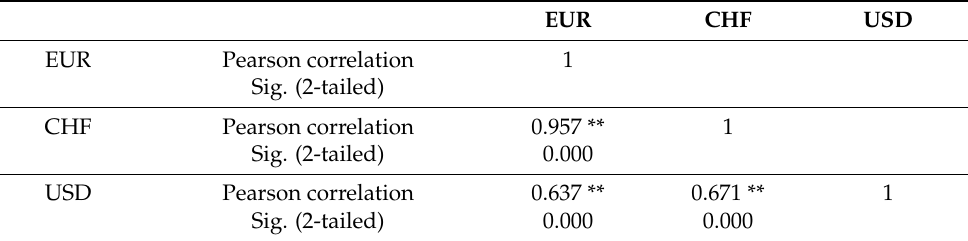
Table 4. Pearson’s correlation between 6-month LIBOR major currencies, 2 January 2002–2 December